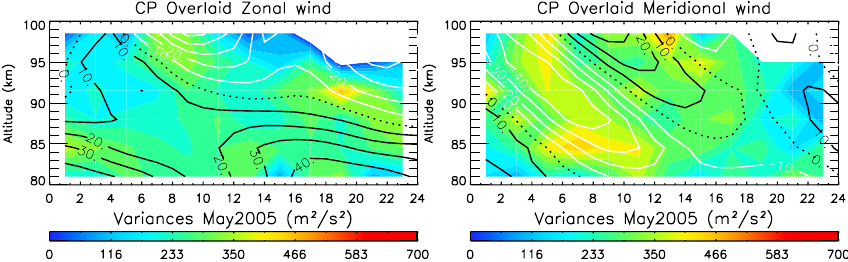
Fig. 18. Zonal (left) and meridional (right) wind variances for May 2005 over Cachoeira Paulista (23 ◦ S, 45 ◦ W) using MCD analysis. The line contour overlaying the variances is the total wind, black lines mean positive values, and white lines negative values. The dashed line indicates where the wind is zero.